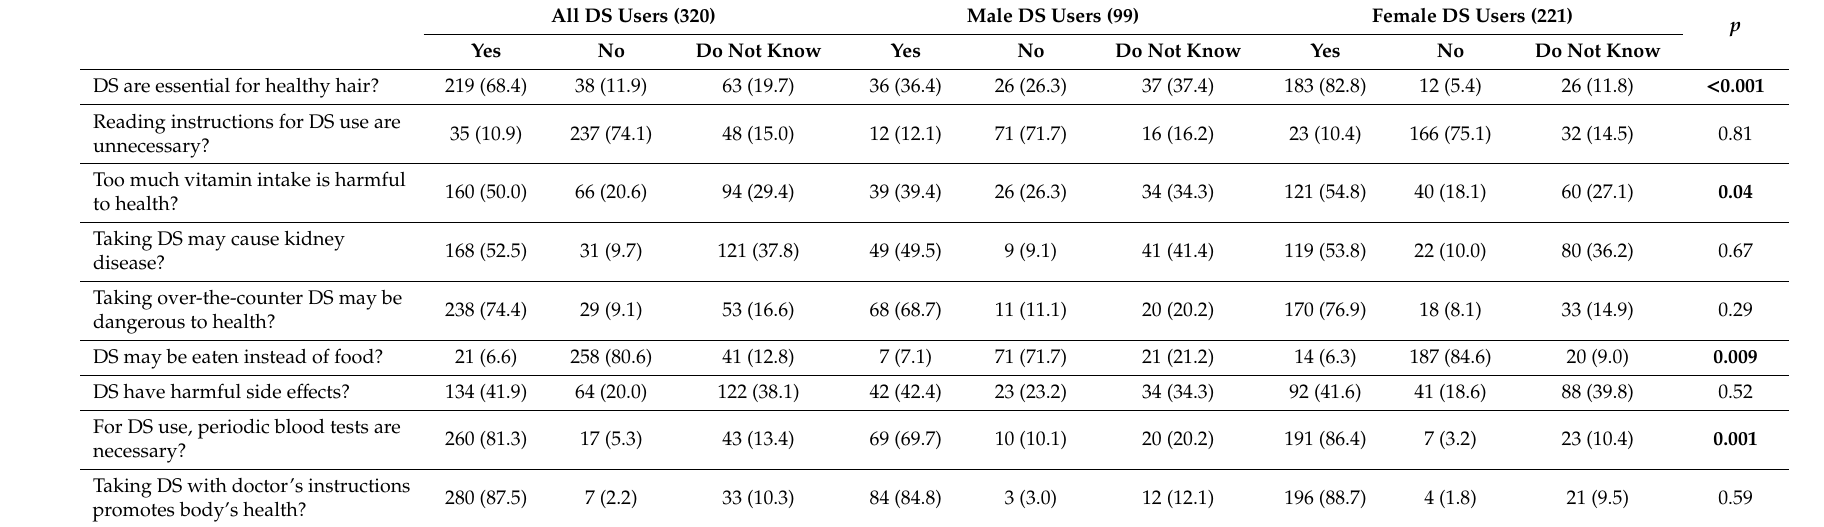
Table 4. Awareness about dietary supplement use among